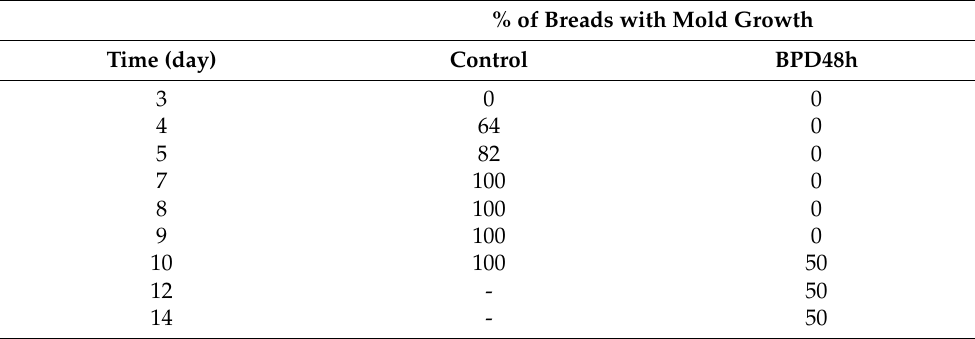
Table 4. Mold growth on control bread and bread incorporated with fermented polish-type sourdough with Lactiplantibacillus plantarum NRRL